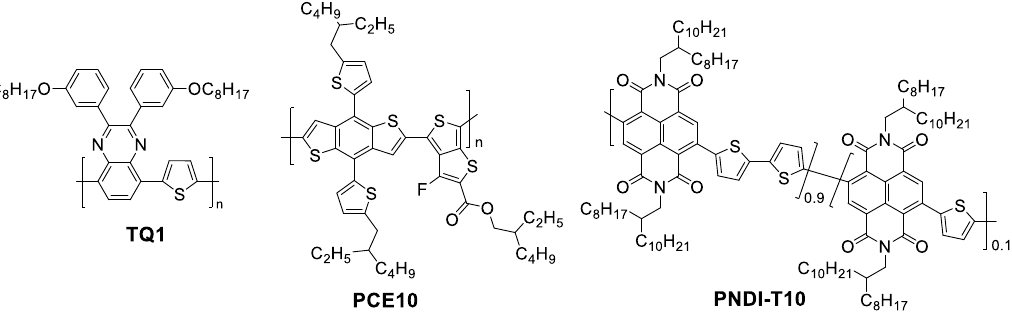
Figure 1. Chemical structures of poly[2,3-bis(3-octyloxyphenyl) quinoxaline-5,8-diyl-alt-thiophene- 2,5-diyl] (TQ1), poly[4,8-bis[5-(2-ethylhexyl)-2-thienyl]benzo[1,2-b:4,5-b′] dithiophene-alt -(4-(2- ethylhexyl)-3-fluorothieno[3,4-b]thiophene-)-2-carboxylate-2-6-diyl]] (PCE10), and PNDI-T10.